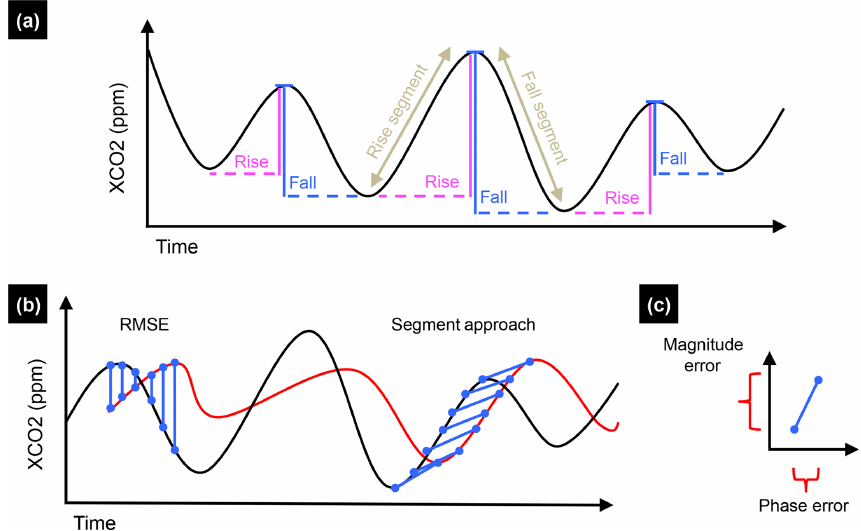
Figure 1. Conceptual diagram for the segmentation analysis. (a) Interannual variation in seasonal cycle amplitudes (vertical, solid colored lines) and periods (horizontal, dashed colored lines); such interannual variation may also differ among rise and fall segments. (b) A reference cycle (black) and a modeled seasonal cycle (red) are compared using the root-mean-square error (RMSE), which is taken as the difference in magnitude at the same exact time in reference and modeled seasonal cycles. In out-of-phase signals, the RMSE misrepresents bias. The segmentation approach matches segments in the reference and modeled seasonal cycles, rise to rise and fall to fall, so that the errors in magnitude and phase can be decomposed and directly represented (c)